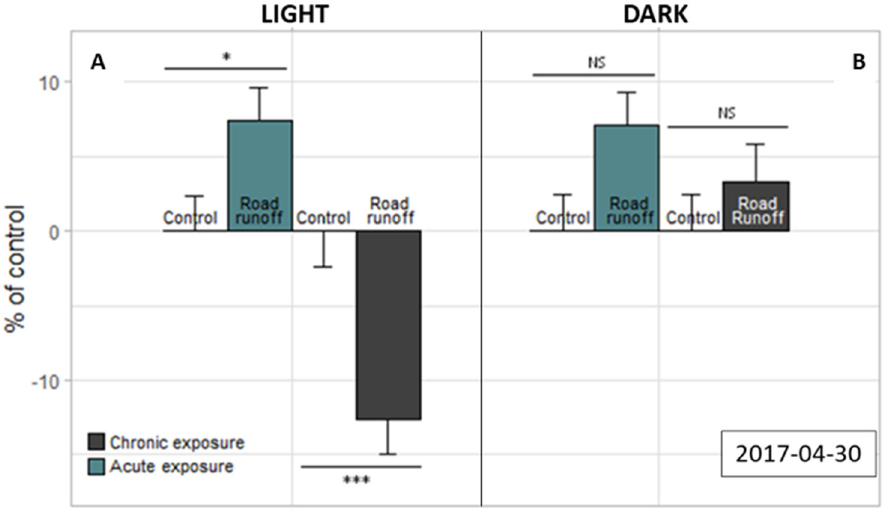
Figure 2. Activity (% of control) of 6 dpf old zebrafish larvae exposed to RR from R site in chronical and acute exposure. Light period ( A ); dark period ( B ). control = E3 solution; number of larvae = 36 per condition; NS = not significant; * = p -value < 0.05; ** = p -value < 0.01; *** = p -value < 0.001 (non- parametric Kruskal–Wallis test). Error bars represent the standard error.